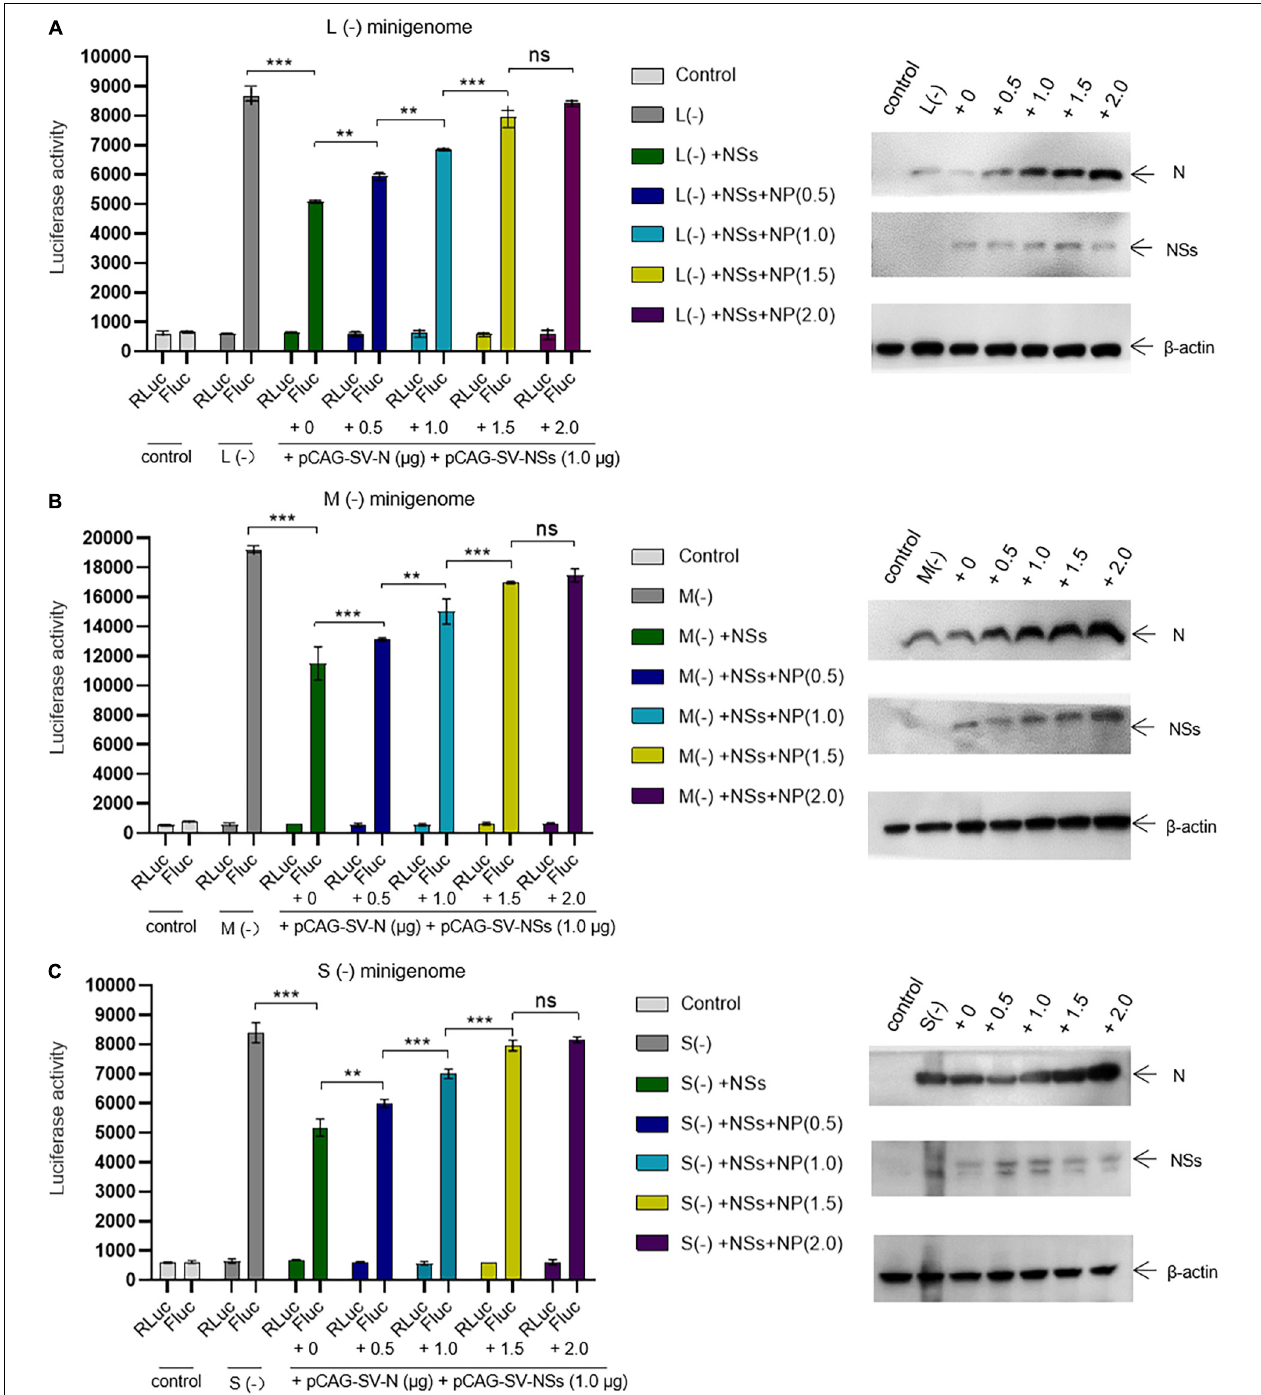
FIGURE 5 | The negative regulatory effect of NSs on virus-like RNA synthesis can be outcompeted by increasing the level of N. Minigenome reporter assays combined with Western blotting analysis was carried out to investigate whether the accumulation of N reverses the negative regulatory effect on virus-like RNA synthesis. Minigenome reporter assays were carried out as described above. Briefly, BHK-21 cells cultured in 12-well plates were transfected with 1.0 µ g of pRF42-L/M/SUTR-FLuc (–), 0.5 µ g of pCAG-SV-RdRp, and 0.5 µ g of pCAG-SV-N together with 10 ng of internal control plasmid (pRL-TK). Meanwhile, control groups with pRF42-L/M/SUTR-FLuc (–) being replaced with pRF42-FLuc were set, respectively. Moreover, cells transfected with plasmid mixes of L (–), M (–), and S (–) with 0.5 µ g of NSs protein expression plasmids pCAG-SV-NSs are also transfected with various amount of additional N expression plasmids pCAG-SV-N (0, 0.5, 1.0, 1.5, and 2.0 µ g, respectively). After 48 h, firefly and Renilla luciferase were measured. Data are presented as the mean ± SEM ( n = 3). ** p < 0.01; *** p < 0.001; ns, non-significant ( A–C , left). To confirm the expression of NSs and the accumulation of N, Western blotting was conducted ( A–C ,